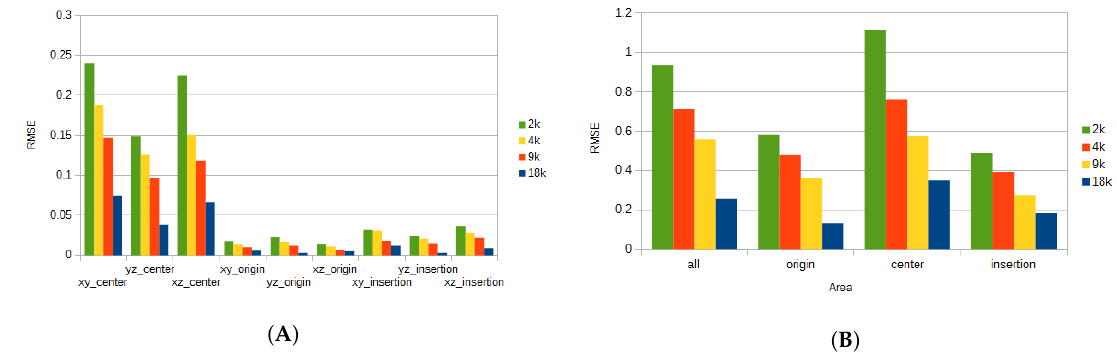
Figure 8. Average error for all the FEM resolutions for different regions for the triceps. ( A ) shows the average displacement error for all particle resolutions. ( B ) shows the average pressure error for all particle resolutions.